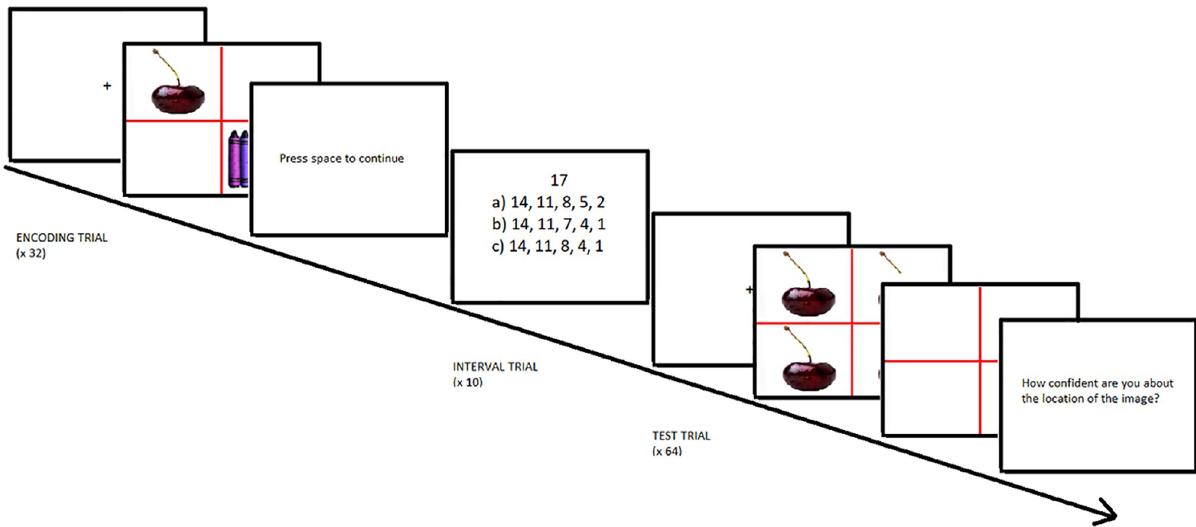
Fig 1. Sequence of events during the session. The figure shows examples of the types of screens encountered by participants in the encoding phase, retention interval and test phase. Please see Methods section for specifics of the timing and participant instructions.